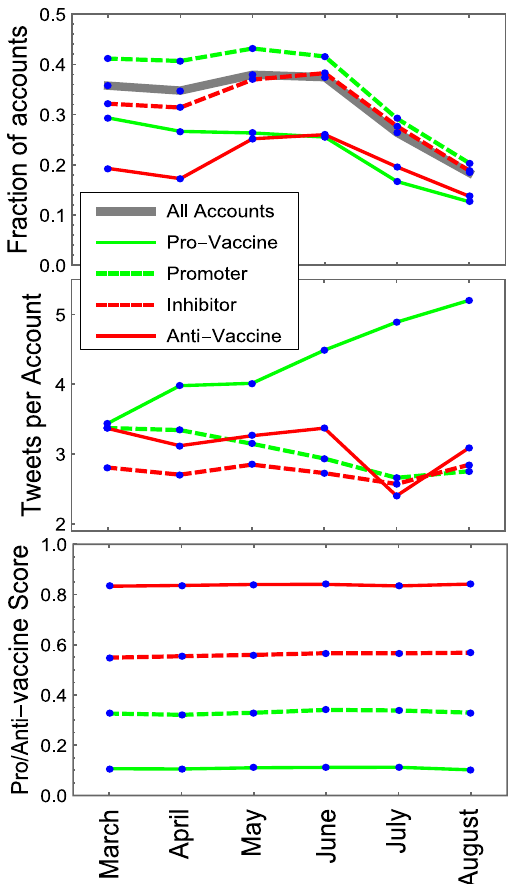
Figure 3. Temporal dynamics of the accounts and activity per category. Monthly values of the fraction of active accounts (that tweeted at least once in a month), number of tweets per account, and opinion scores for each category. Although the number of active accounts appears to increase in periods of controversy regarding vaccination, their mean opinions and activity do not significantly change. The sustained activity increase of pro- vaccine accounts can be attributed to the proliferation of informative messages and appeals to get vaccinated by organizations related to the vaccination